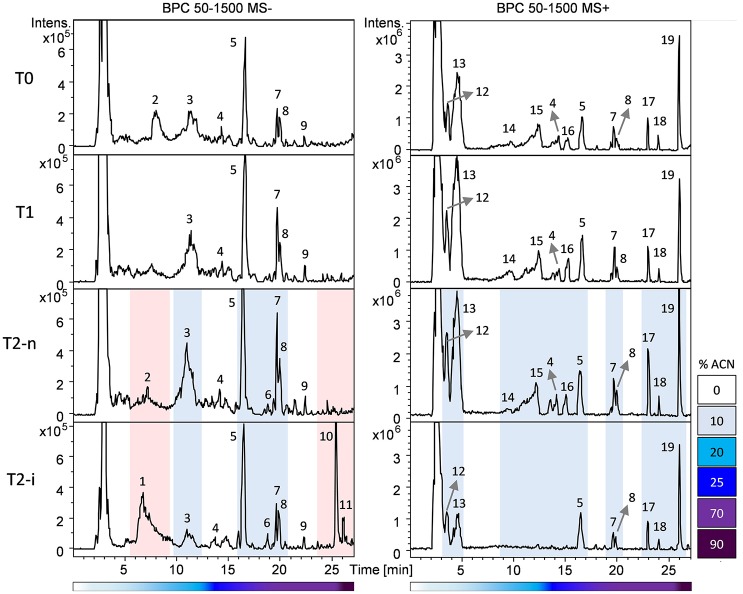
Base peak chromatograms (BPC) recorded in negative (left) and positive (right) ionization mode based on the RP-HPLC-ESI-MS analysis of T0, T1, T2-n, and T2-i berry samples. Peak numbers refer to the metabolites listed in Table 1. Chromatogram areas are highlighted to show the reduction (in blue) or the accumulation (in red) of metabolites in T2-i grapes relative to naturally withered grapes (T0, T1, T2-n). The lower bars refer to the percentage of acetonitrile (ACN) in the mobile phase.